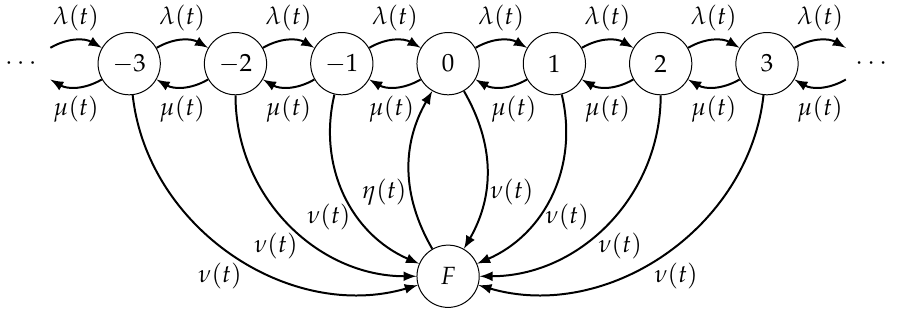
Figure 2. State diagram of the time-non-homogeneous double-ended queueing system with catastrophes and